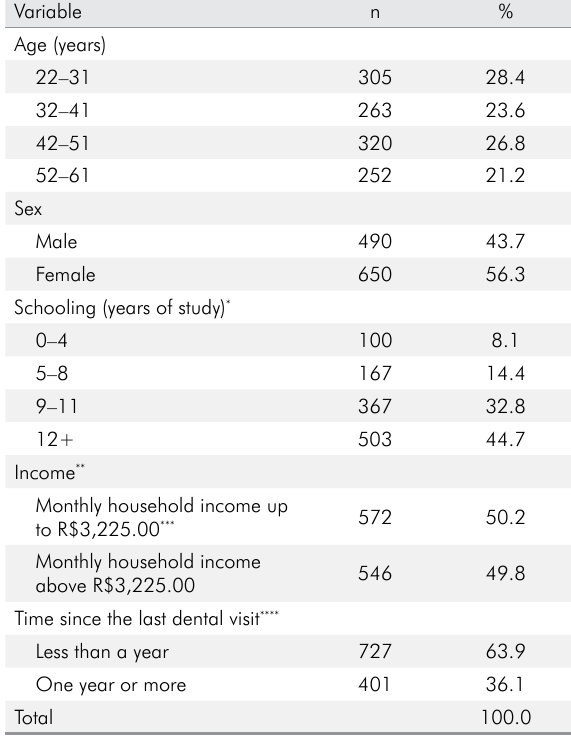
Table 1. Participant’s socioeconomic and demographic characteristics (n = 1,140). EpiFloripa Study, Florianópolis, Southern Brazil,